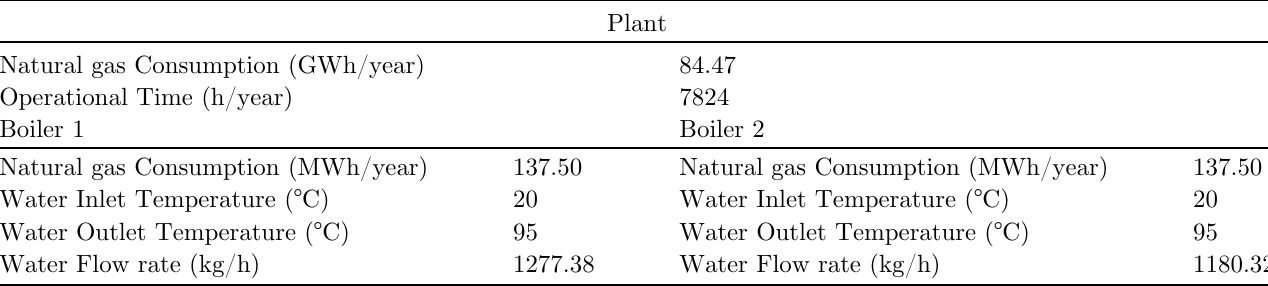
Table 1. Technical speci fi cations of the plant and the two boilers.